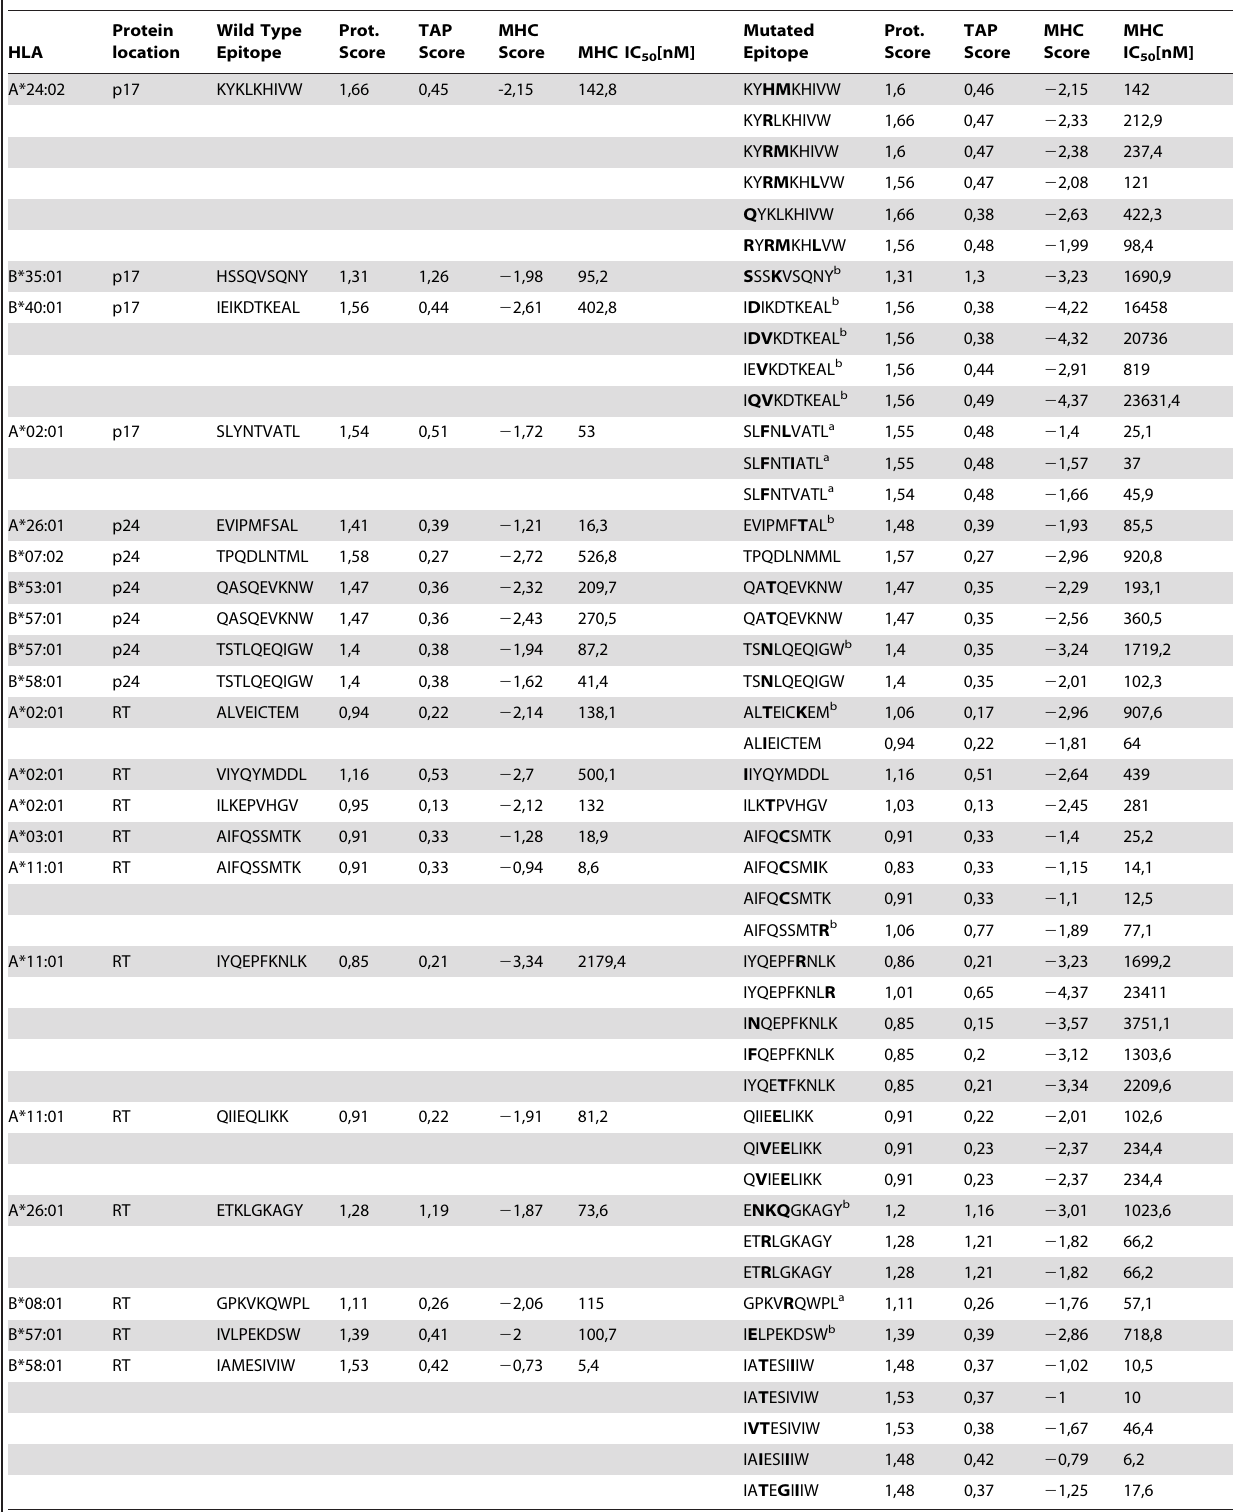
Table 3. Proteasome, TAP and MHC score of CTL epitopes.